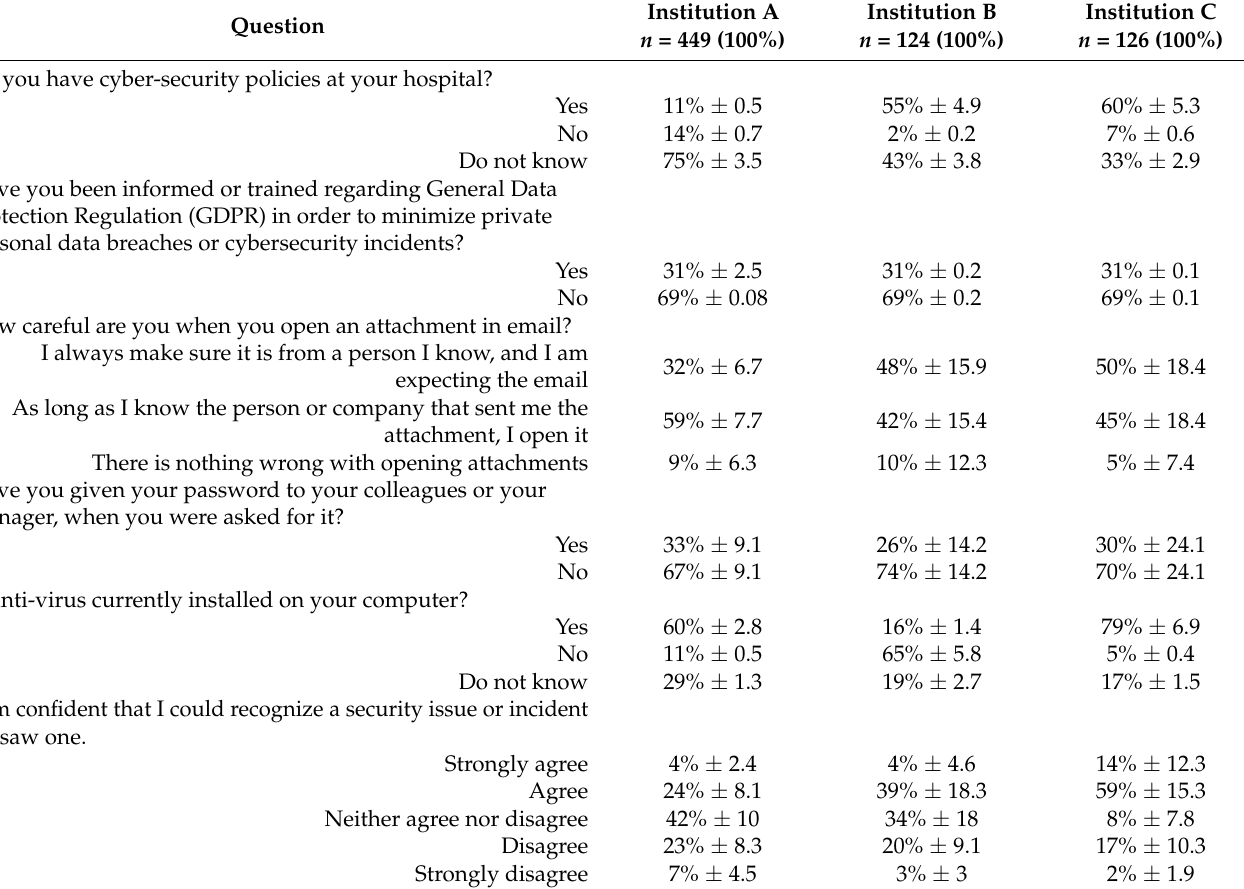
Table 1. Percentage (%) of answers related to cybersecurity awareness along with the corresponding standard deviations for non-ICT